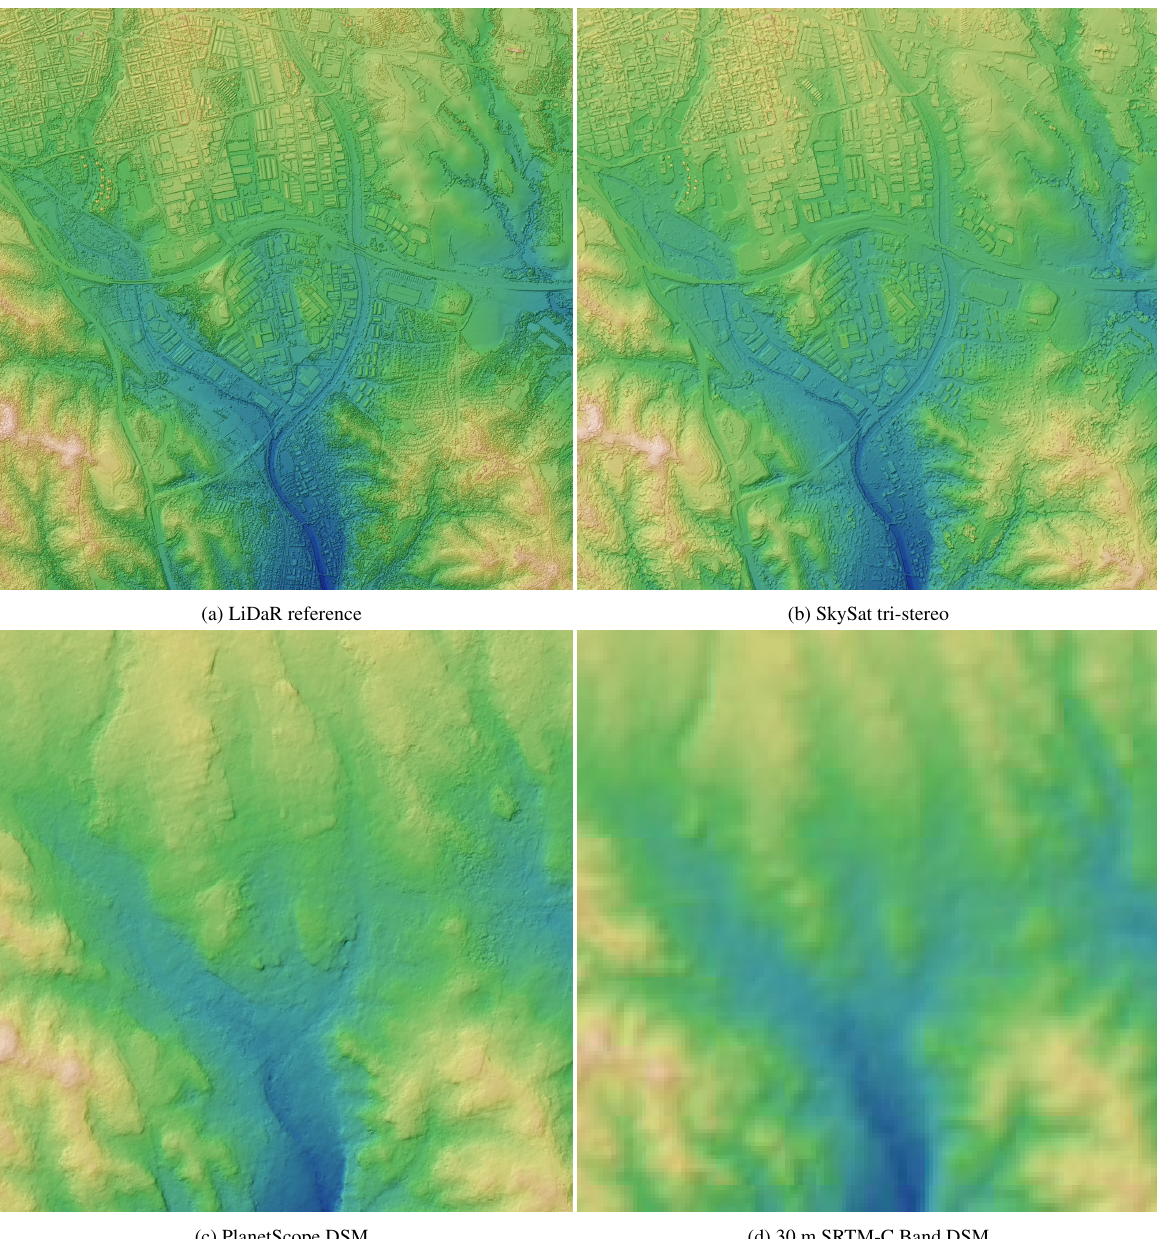
Figure 7. Different DSMs over the Terrassa